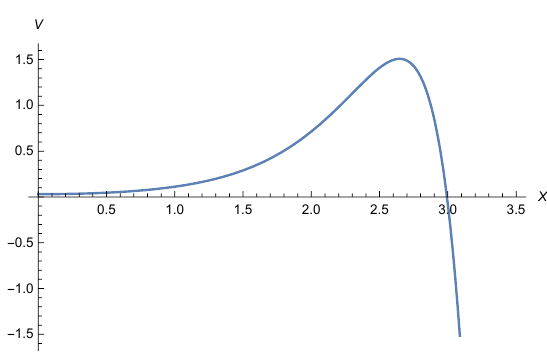
Figure 9. Einstein frame radion potentials for l UV = 10 and l IR = 9 :